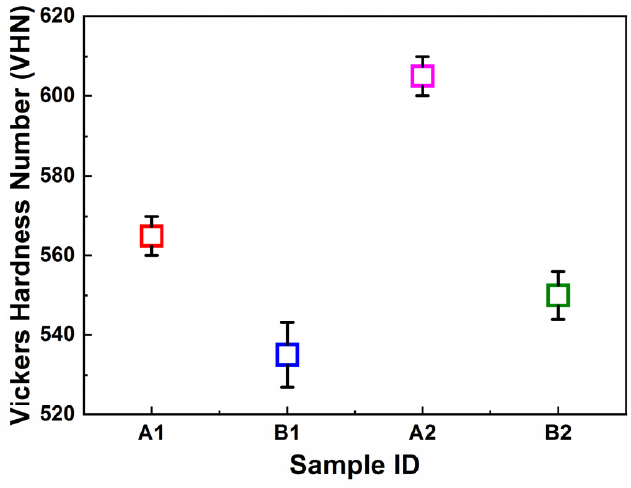
Figure 9. Vickers microhardness of ballistic steel samples.